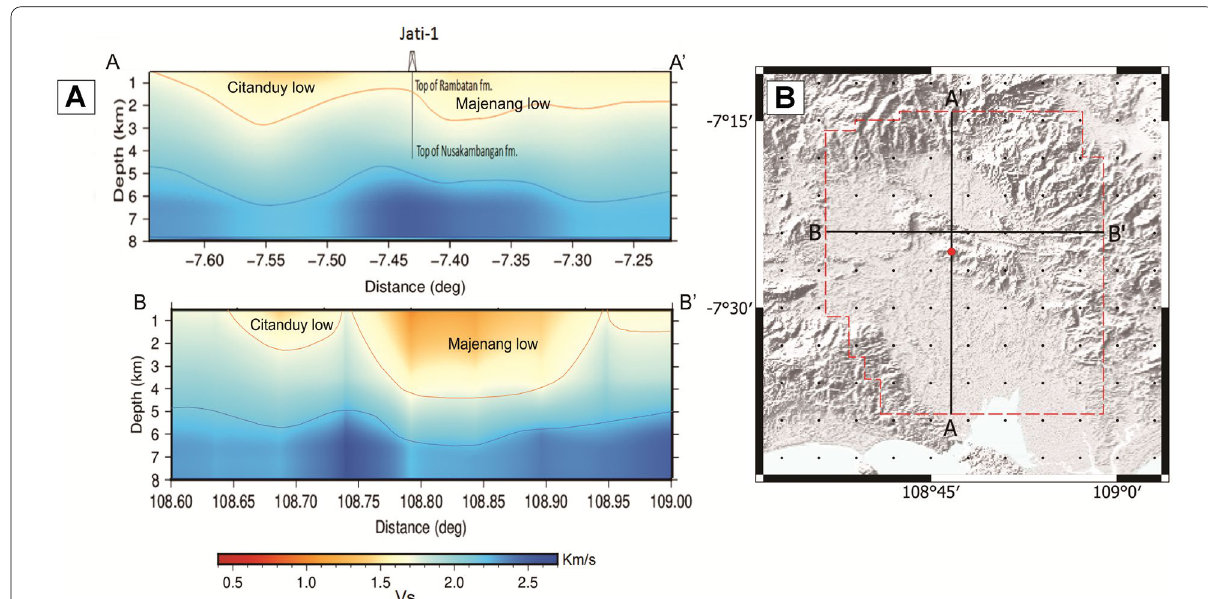
Fig. 7 A Vertical cross section of Vs structure for lines A–A’ and B–B’ at longitude 107.776° and latitude map is denoted by black lines, the red dashed lines are the limits of the ANT tomographic resolution, and the red dot is the location of the Jati-1